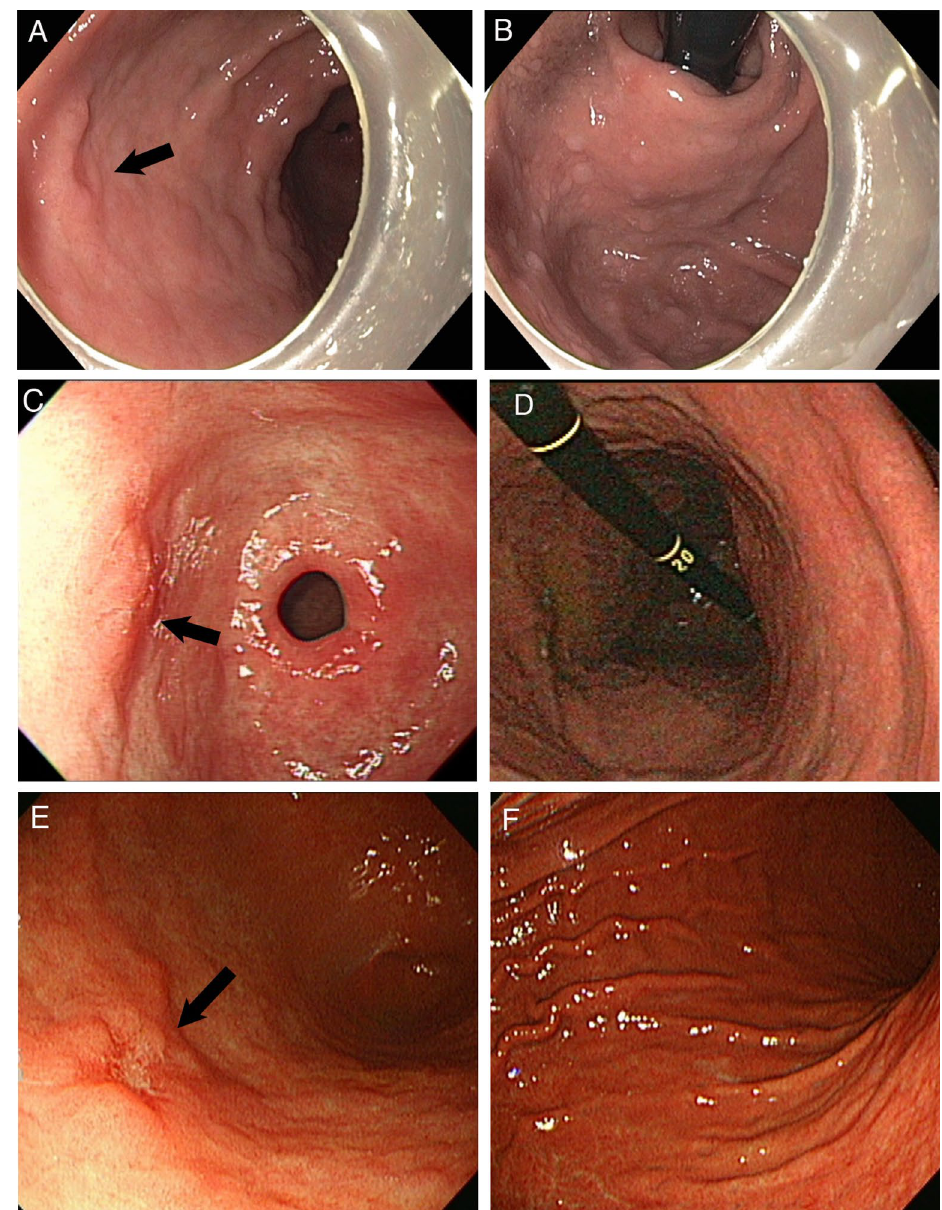
Figure 3. Upper gastrointestinal endoscopic views of the three patients. (Patient 1: A, B, Patient 2: C, D, Patient 3: E, F). All three gastric cancers are located in the anterior wall of antrum. Arrow: Cancer. ( A ) Gastric cancer of Patient 1 is located in the anterior wall of antrum. Macroscopically 0-IIc type superficial depressed type. ( B ) Cardia of Patient 1. Atrophy and gastritis are minimal. Multiple white flat elevations are observed. ( C ) Gastric cancer of Patient 2 is located in the anterior wall of pre-pylorus. Macroscopically 0-IIc type superficial depressed type. The background mucosa shows edema. ( D ) Corpus of Patient 2. The corpus mucosa shows no atrophy and gastritis. ( E ) Gastric cancer of Patient 3 is located in the anterior wall of antrum. Macroscopically 0-IIc type superficial depressed type. The background mucosa shows atrophy. ( F ) Corpus of Patient 3 shows atrophic gastritis with diffuse